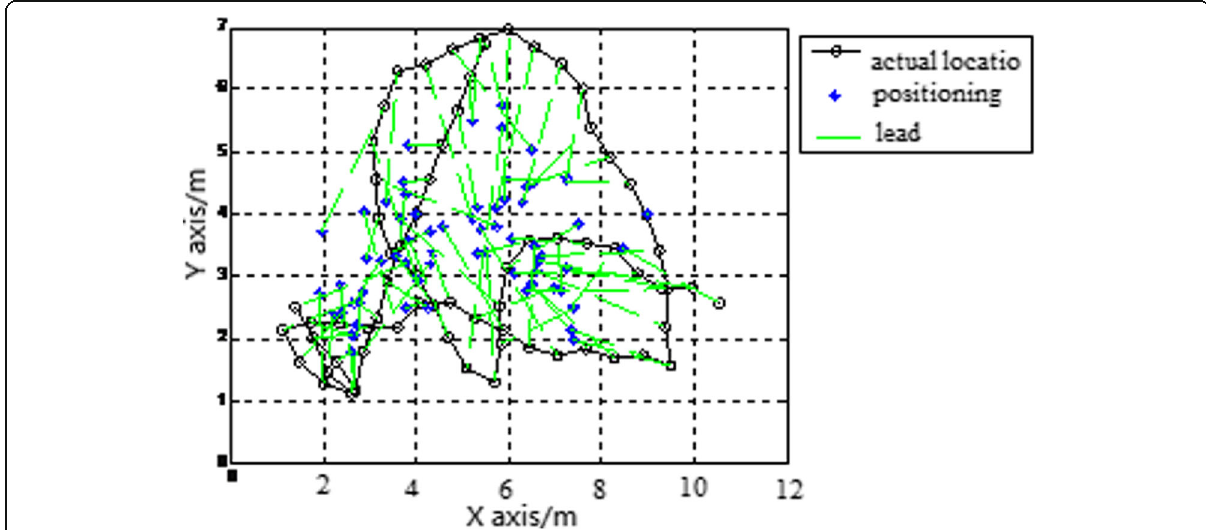
Fig. 7 The result of positioning analysts based on distance weighting